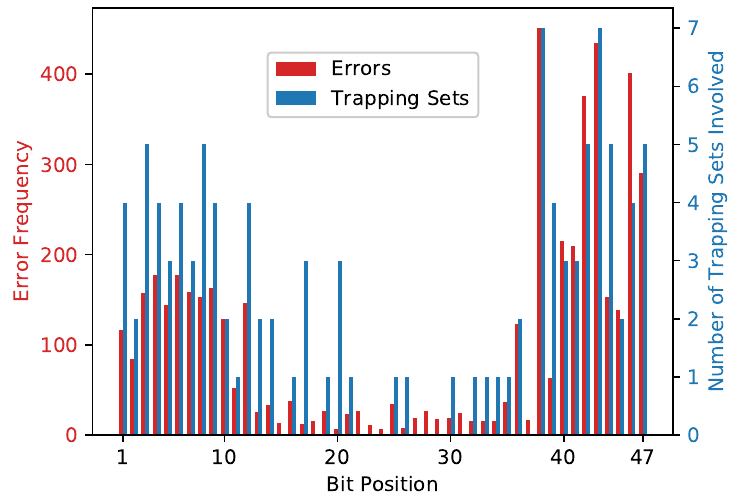
Figure 4. Trapping sets and errors distribution of the (47,24) QR code. More than 5000 errors are counted after 5 TAMS iterations by simulation at E b / N 0 = 8dB. The trapping sets distribution is calculated by counting the occurrences of nodes in small trapping sets ( a + b < 7 and a < 4).